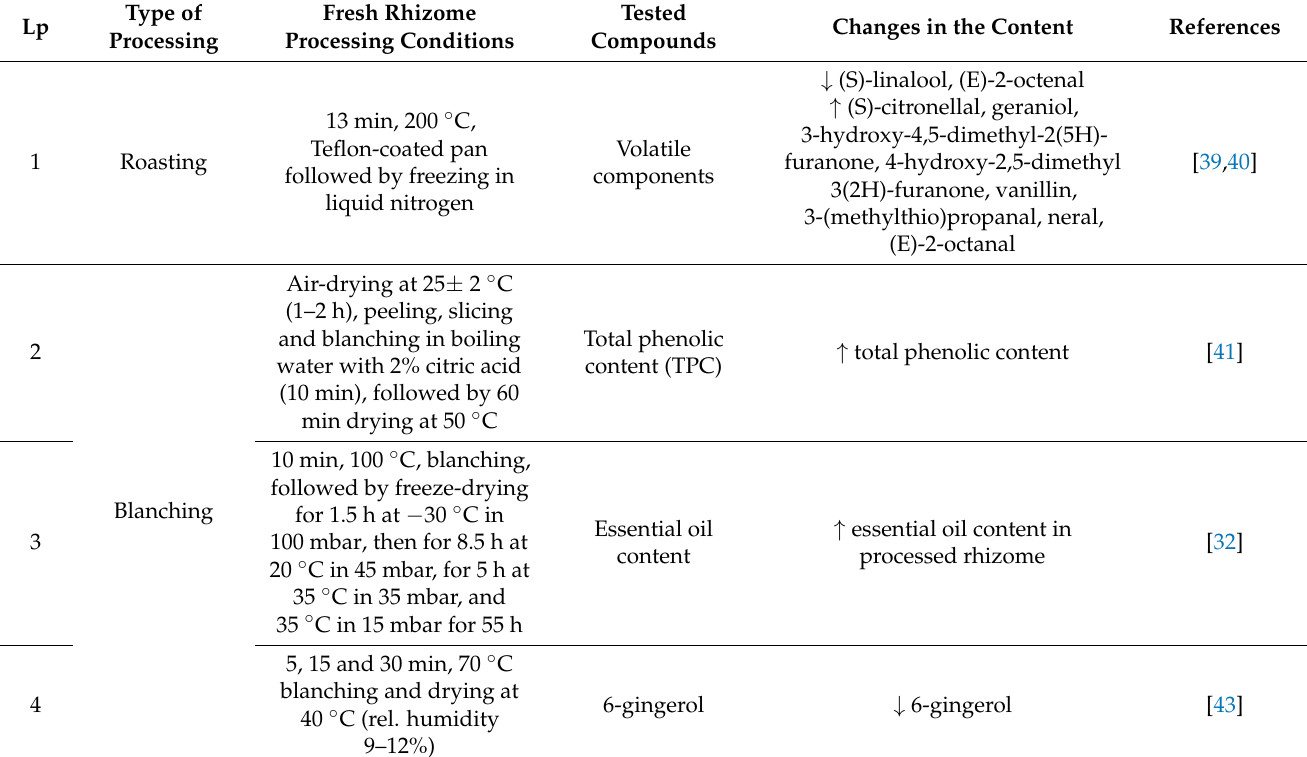
Table 1. Effect of traditional processing on the content of secondary metabolites in